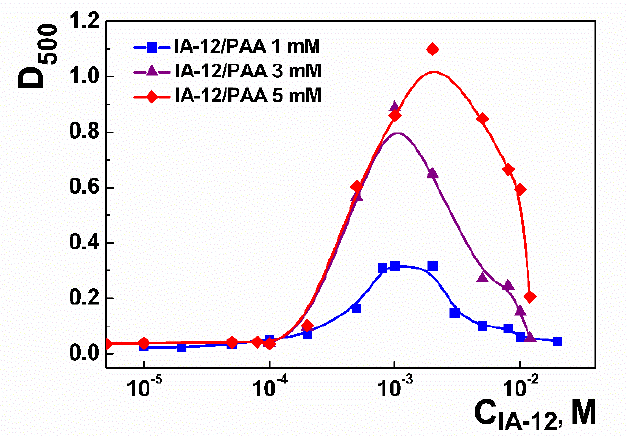
Figure 5. Optical density at λ = 500 nm versus IA-12 concentration plot for the IA-12/PAA binary systems; C PAA = 1, 3, 5 mM, 25 °C. systems; C ◦ PAA = 1, 3, 5 mM, 25